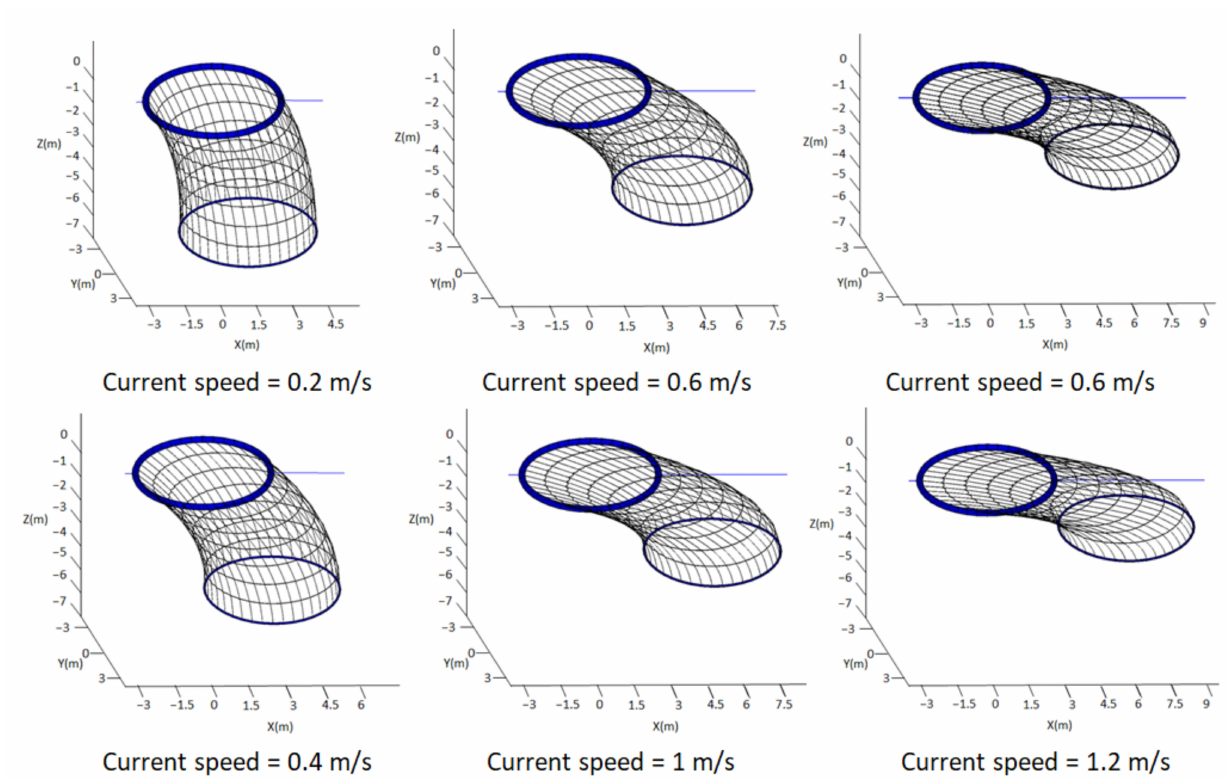
Figure 5. Variations of different current speeds on the cage displacements with a wave height = 1 m and wave period = 10 s, and the other parametric values are the same as mentioned in Table